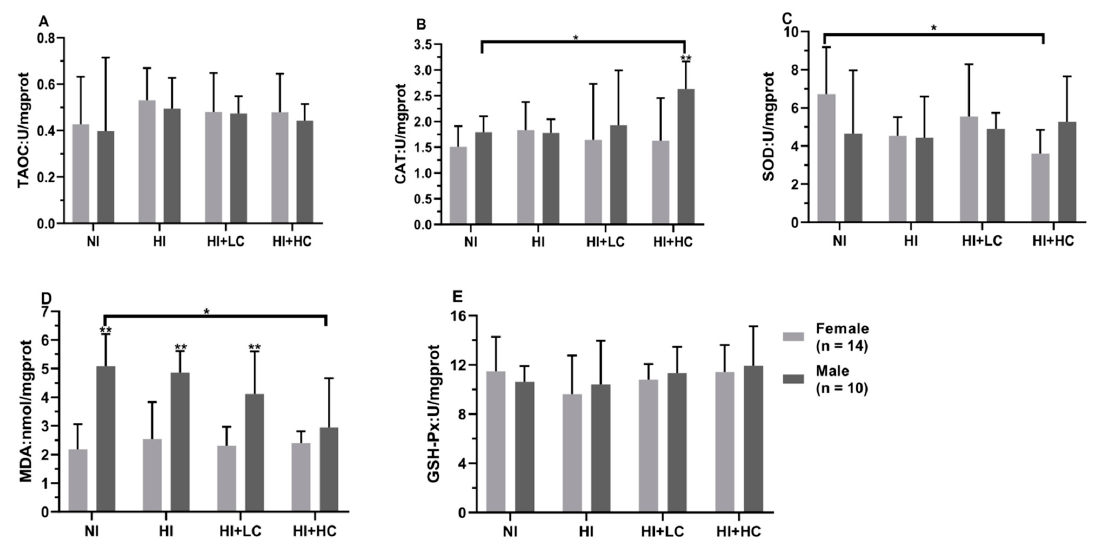
Figure 5. Protection of vitamin C from oxidative damage in the thyroid for different sexes. ( A ) The activity of TAOC; ( B ) The activity of CAT; ( C ) The activity of SOD; ( D ) The content of MDA; ( E ) The activity of GSH-Px. All data are presented as mean and deviation. ** represents the difference between female and male being statistically significant, and p < 0.01, and * represents p < 0.05. 3.8. Protection of Vitamin C from Oxidative Damage in the Lens Caused by Excess Iodine Table 4. Protection of vitamin C from oxidative damage in the thyroid.